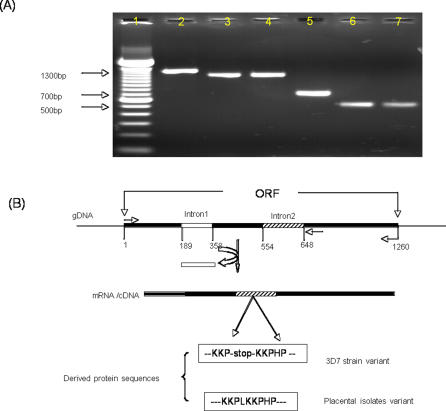
PFI1785w spliced structure.(A) PCR products confirming splicing of intron 1 but not intron 2 on 3D7 and a placental isolate cDNA. Primers indicated on (A) by arrows were used to amplify full size and a short fragment of the gene on 3D7 genomic DNA (lane 2 and 5), and on cDNA of 3D7 (lane 3 and 6) and a placental isolate (lane 4 and 7). Lane 1 indicates a 100 bp DNA lader. (B) Diagram of exon/intron structures from predicted gene and mRNA/cDNA. The heavy bars are predicted exons. Empty and stripped bars are predicted intron 1 and intron 2 respectively according to 3D7 gDNA sequence. Figures below the gDNA structure indicate nucleotide positions. mRNA/cDNA structure is the experimentally observed structure.